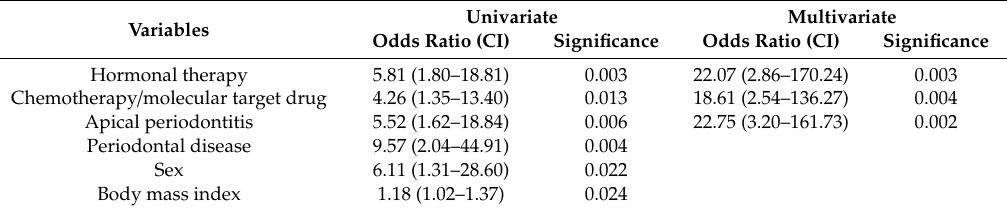
Table 3. Risk factors for DRONJ in multivariate